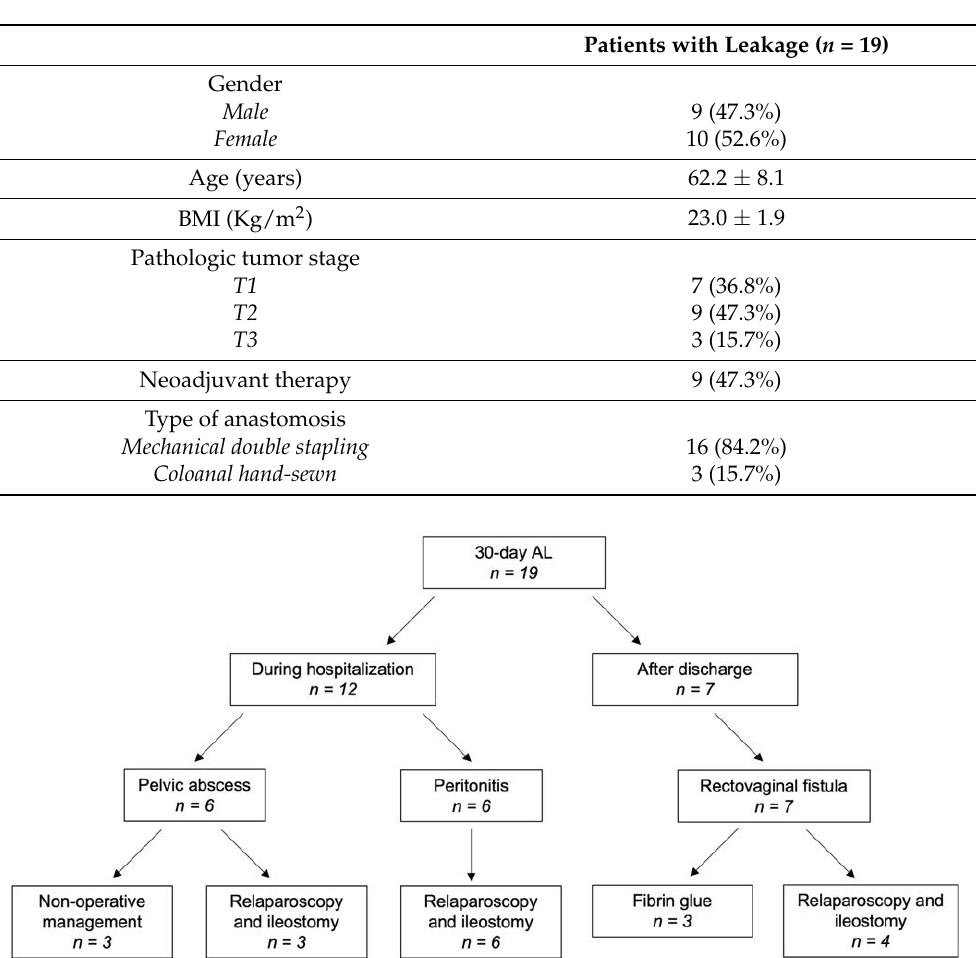
Figure 3. Anastomotic leakage after laparoscopic TME and transanal tube: clinical presentation and management.